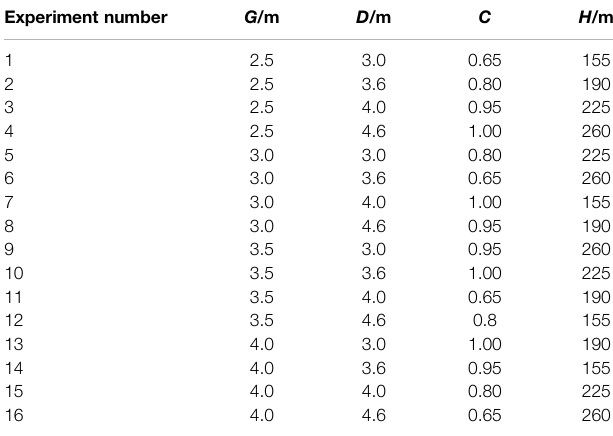
TABLE 3 | Orthogonal experiment table for researching A and k L16(4 4 ).